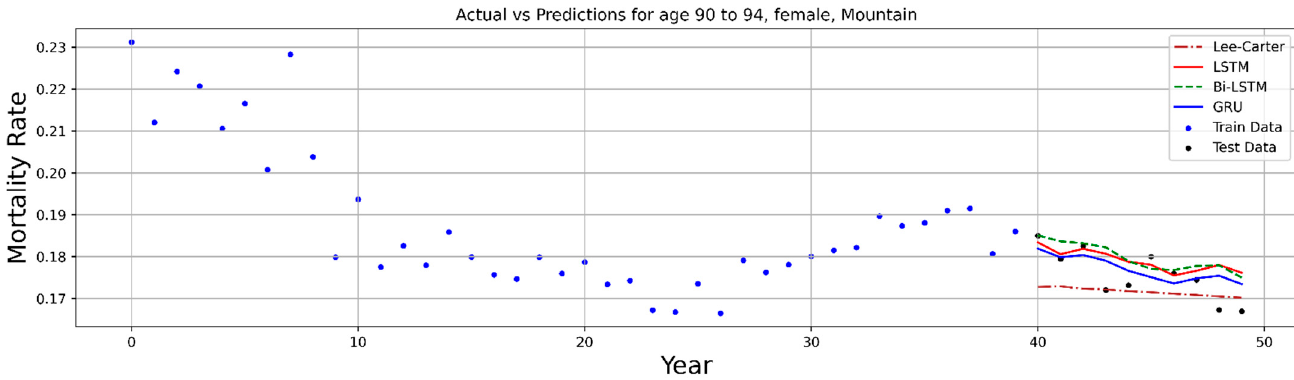
Figure 5. The life expectancy of models in the age group 40–44, Mountain male population.